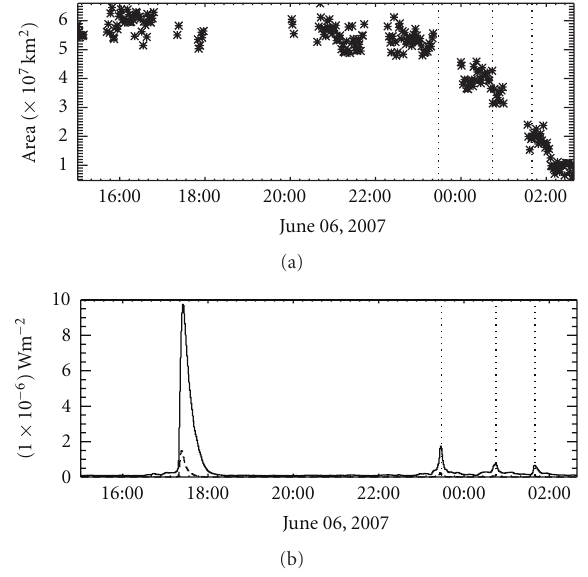
Figure 4: (a) The area of the PLFs is plotted as a function of time. (b) The GOES X-ray flux is plotted as a function of time. The dotted vertical lines from left to right side represent the peak time of C1.7, B7.6, and B6.6 class flares,